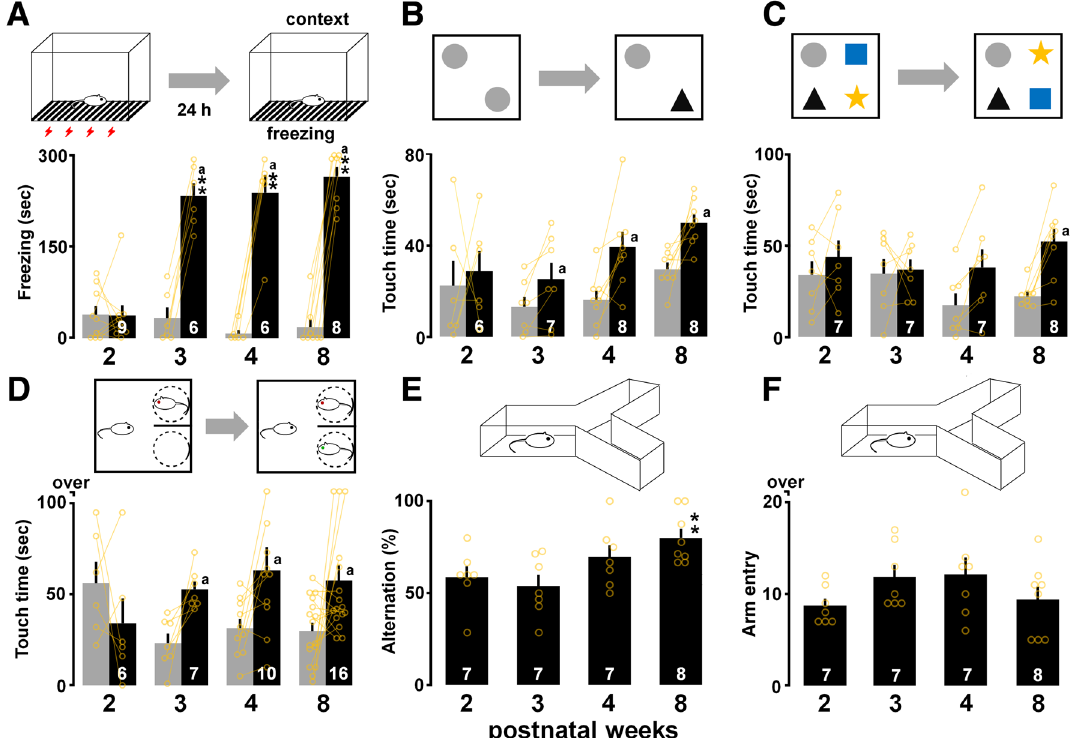
Figure 6. Postnatal changes in other hippocampus-dependent tasks. ( A ) Contextual freezing across training (gray) and testing periods (black). Exposure to context significantly increased averaged freezing time at 3–8 weeks. ( B ) Exploration of familiar (gray) and novel objects (black) in object recognition task. Training increased the touch time of the novel object at 3–8 weeks. ( C ) Exploration of unchanged (gray) and exchanged objects (black) in novel object placement task. Training also increased the touch time of the exchanged objects at 8 weeks. ( D ) Total touch time of familiar (gray) and stranger (black) in social recognition task. Training increased the touch time of the novel target at 3–8 weeks. ( E ) The alternation ratio in the Y-maze test was higher at 8 weeks than it was at 2 weeks. ( F ) Number of total arm entries in the maze. The number of rats is shown at the bottom of each bar. Data are shown as individual points and are the mean ± SEM. * P < 0.05, ** P <